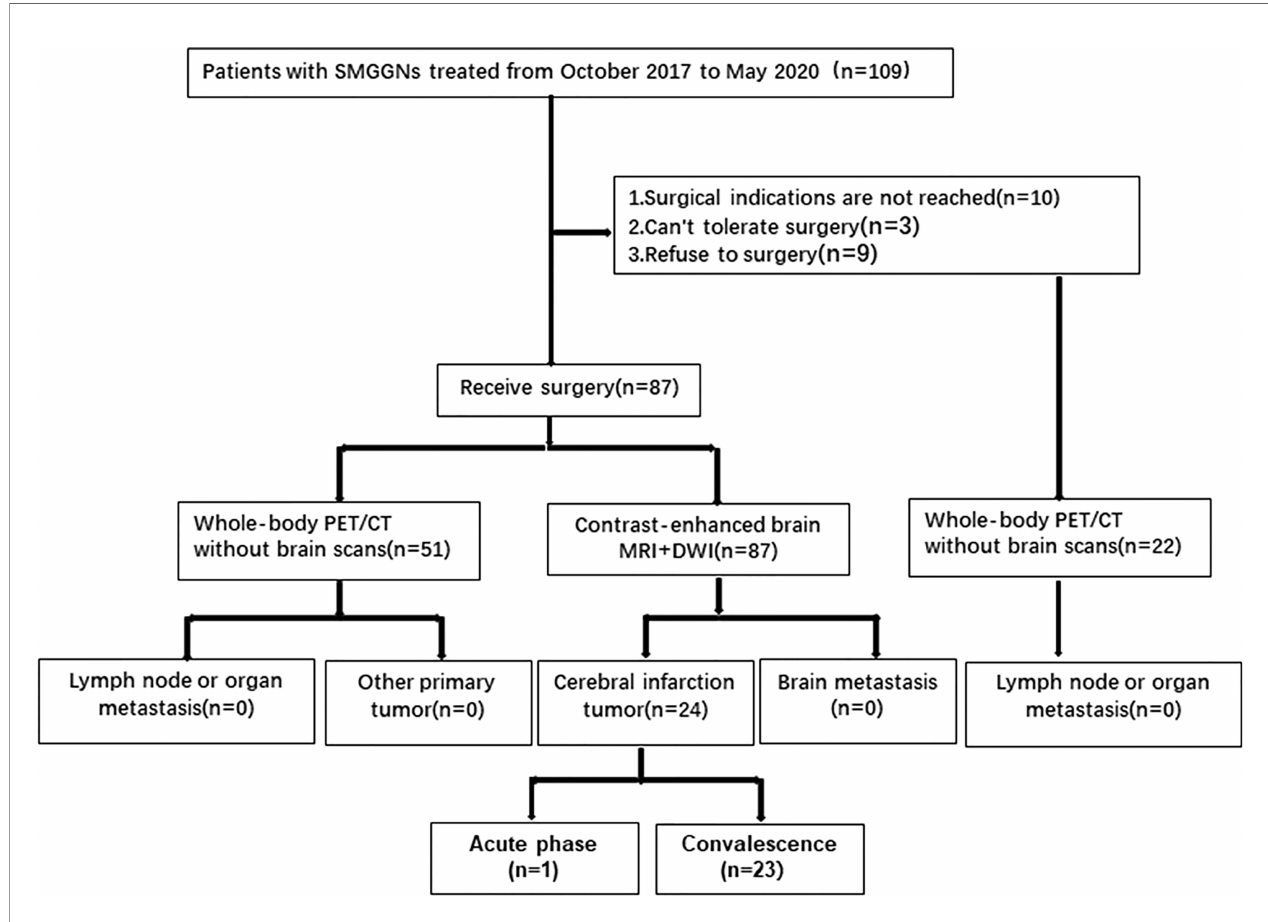
FIGURE 1 | Flow chat of SMGGN patient enrollment and